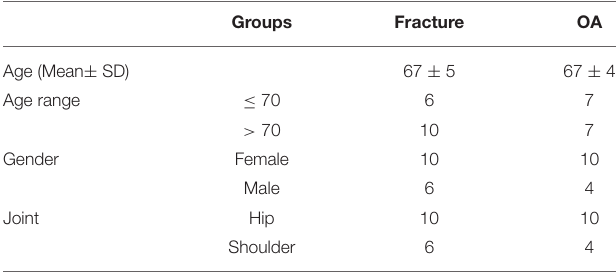
TABLE 1 | Clinical features of patients subjected to arthroplasty secondary to Osteoarthritis (OA) or fracture (control).